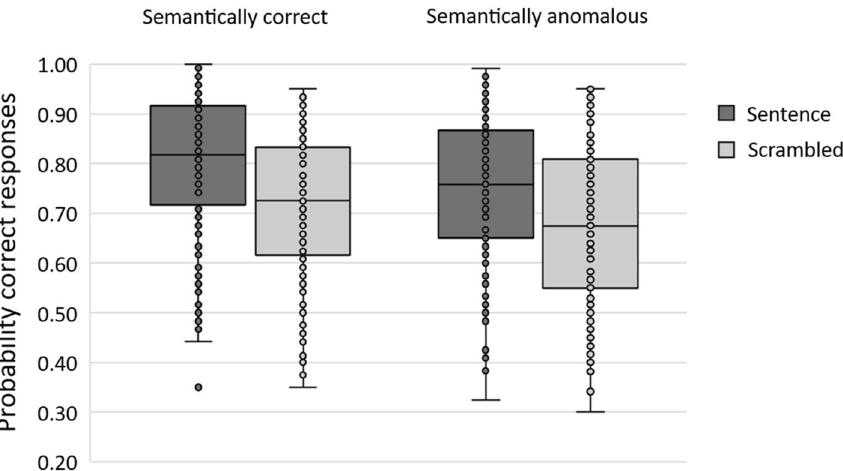
Figure 1. Box-and-whisker plot of the sentence superiority effect (sentence vs. scrambled) obtained with semantically regular and semantically anomalous sentences. Within each box, the horizontal lines denote the median value and the box boundaries indicate the 25th and 75th percentiles. The whiskers mark the 5th and 95th percentiles and each data point represents individual participant